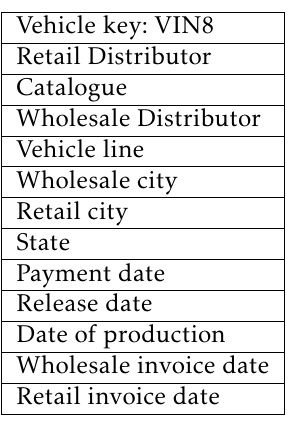
Table 2. The database headers. Table 3. Percentage of allocation by